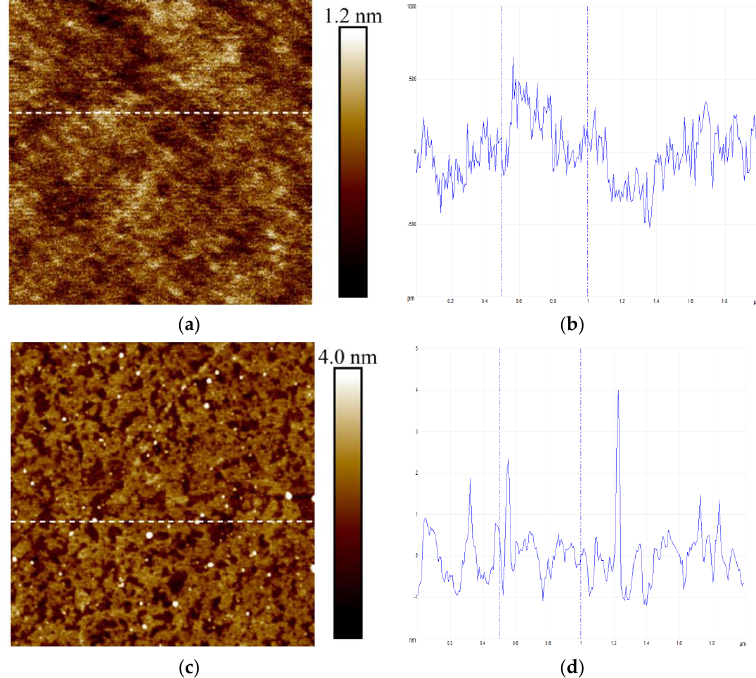
Figure 3. Typical AFM images of the SOI substrate surface ( a , c ) and cross-section profiles corresponding to the thick dashed lines in the AFM images ( b , d ), obtained after the silanization of the substrate surface ( a ), and after the incubation of the substrate in 10-nM solution of CA 125 ( b ). Scan size: 2 × 2 µ m 2 ; Z scale: from 0 to 1.2 nm ( a ), from 0 to 4.0 nm ( b